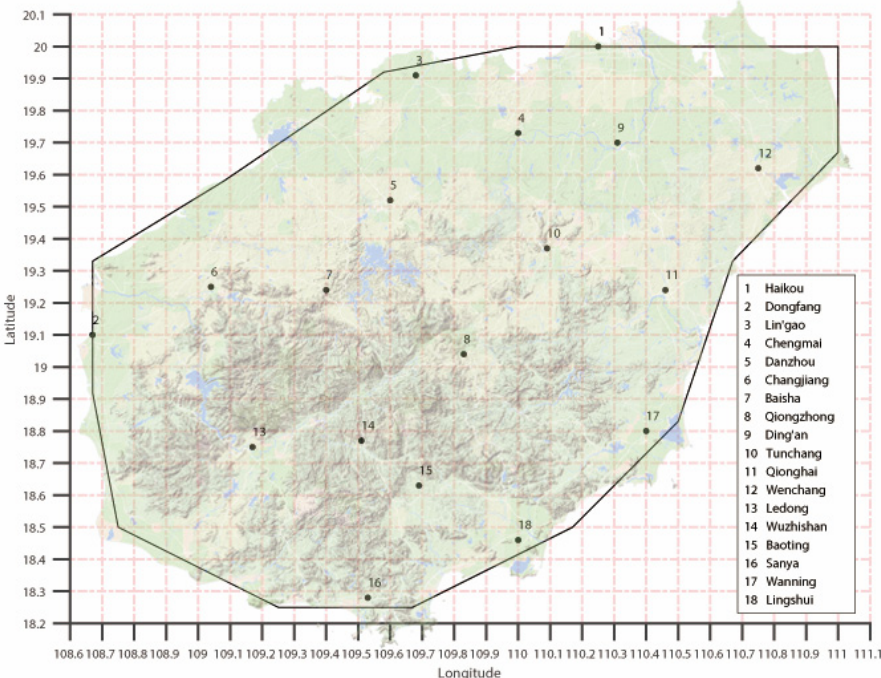
Figure 1. Distribution of the 18 observation stations in Hainan Province.